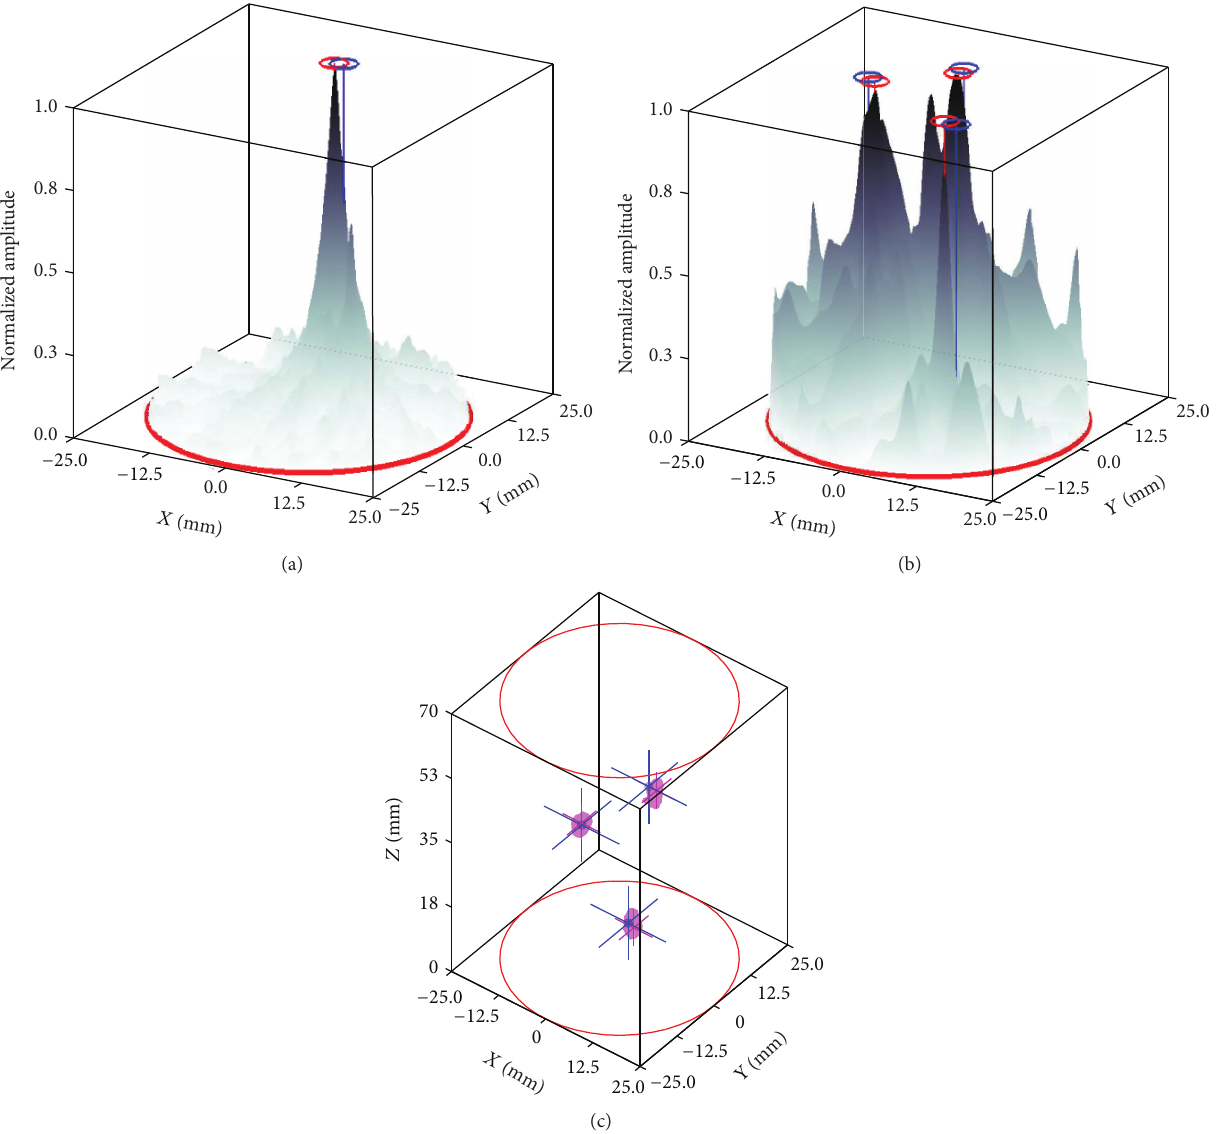
Figure 16: Fluorescence localization results for experimental data obtained with SPADs. (a) One inclusion. (b) Three inclusions in a plane (2D case). (c) Three inclusions in